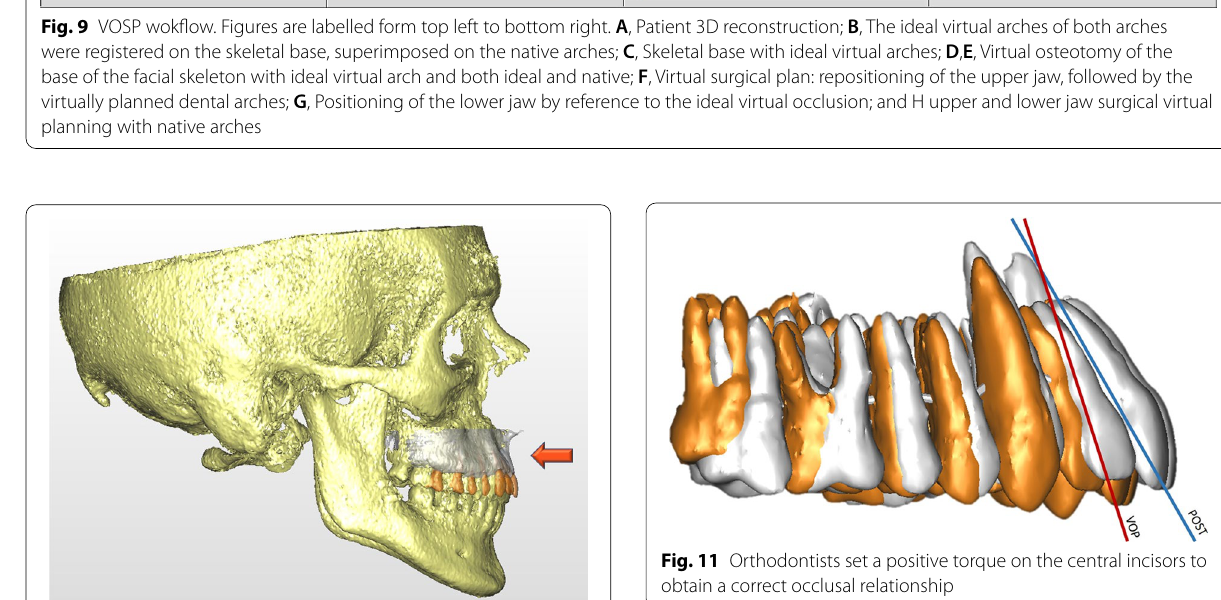
This analysis allowed us to evaluate specific aspects which may hinder the predictability of SF